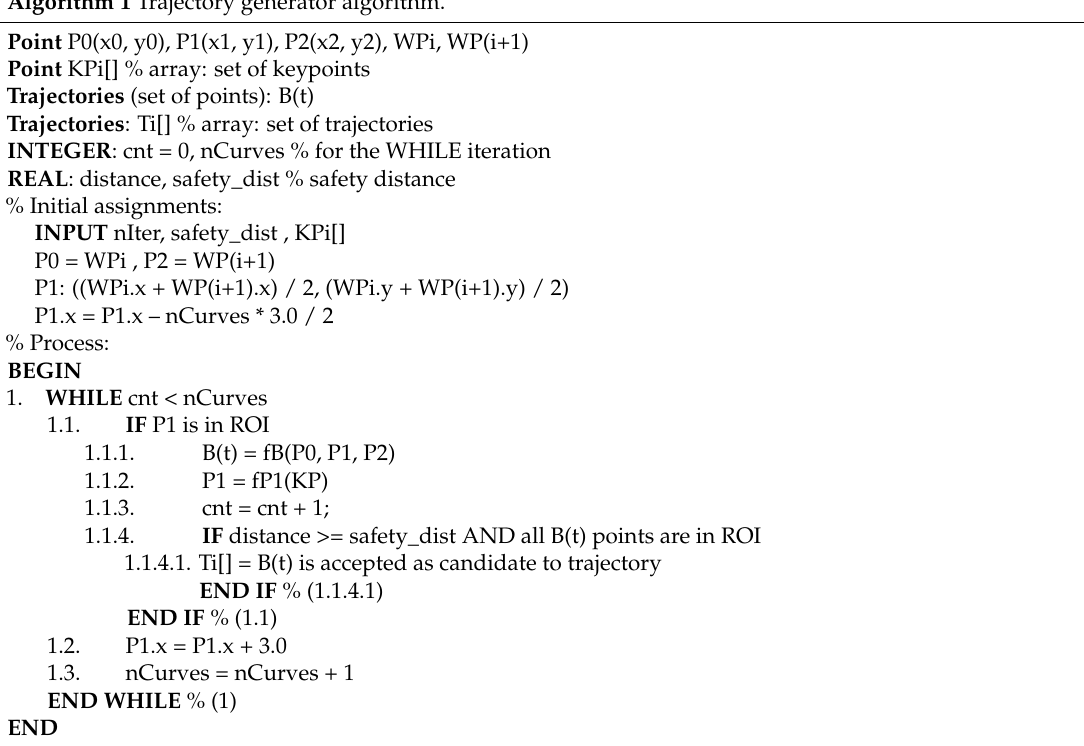
Algorithm 1 Trajectory generator